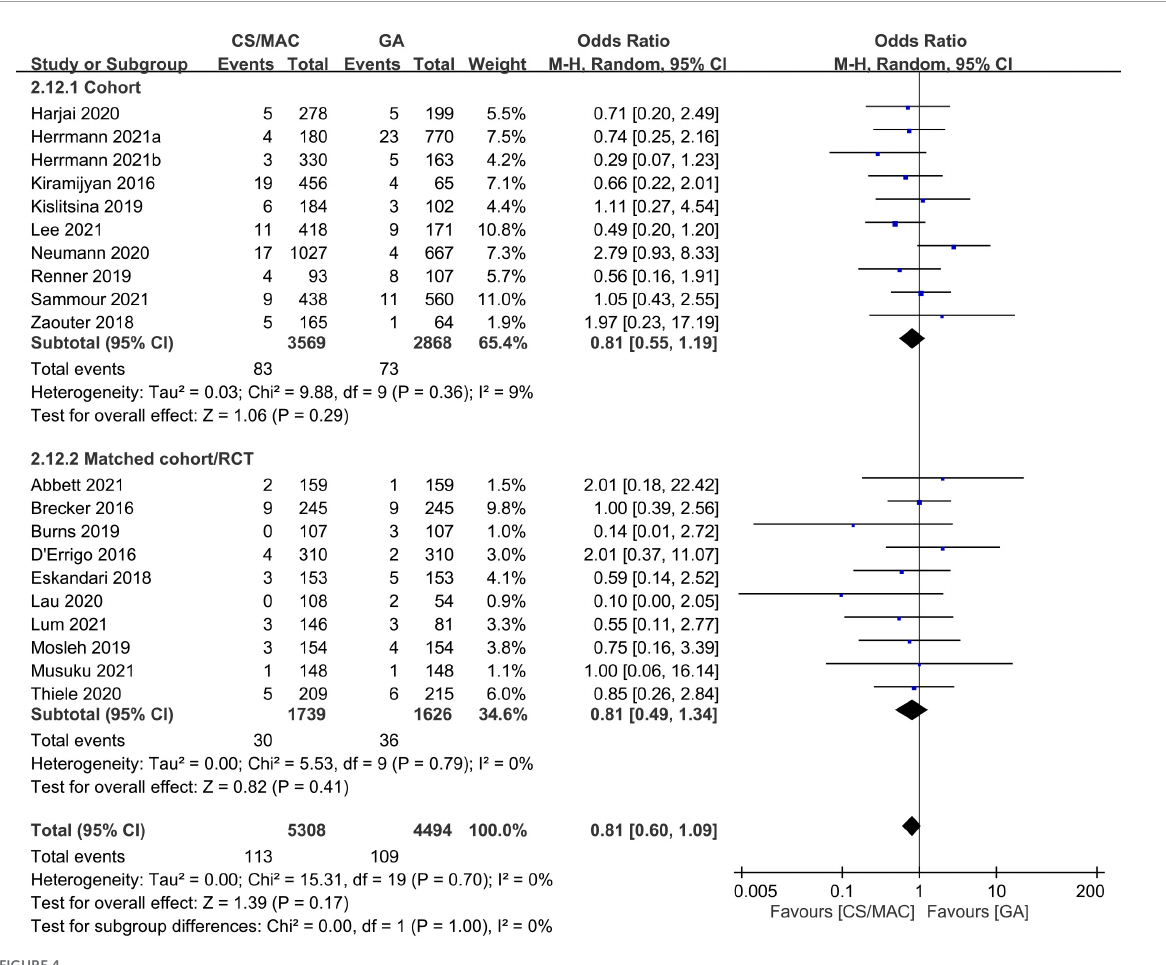
FIGURE4 Forest plot comparing the risk of stroke in patients receiving conscious sedation/monitored anesthesia care (CS/MAC) or general anesthesia (GA). CI, confidence interval; M-H,